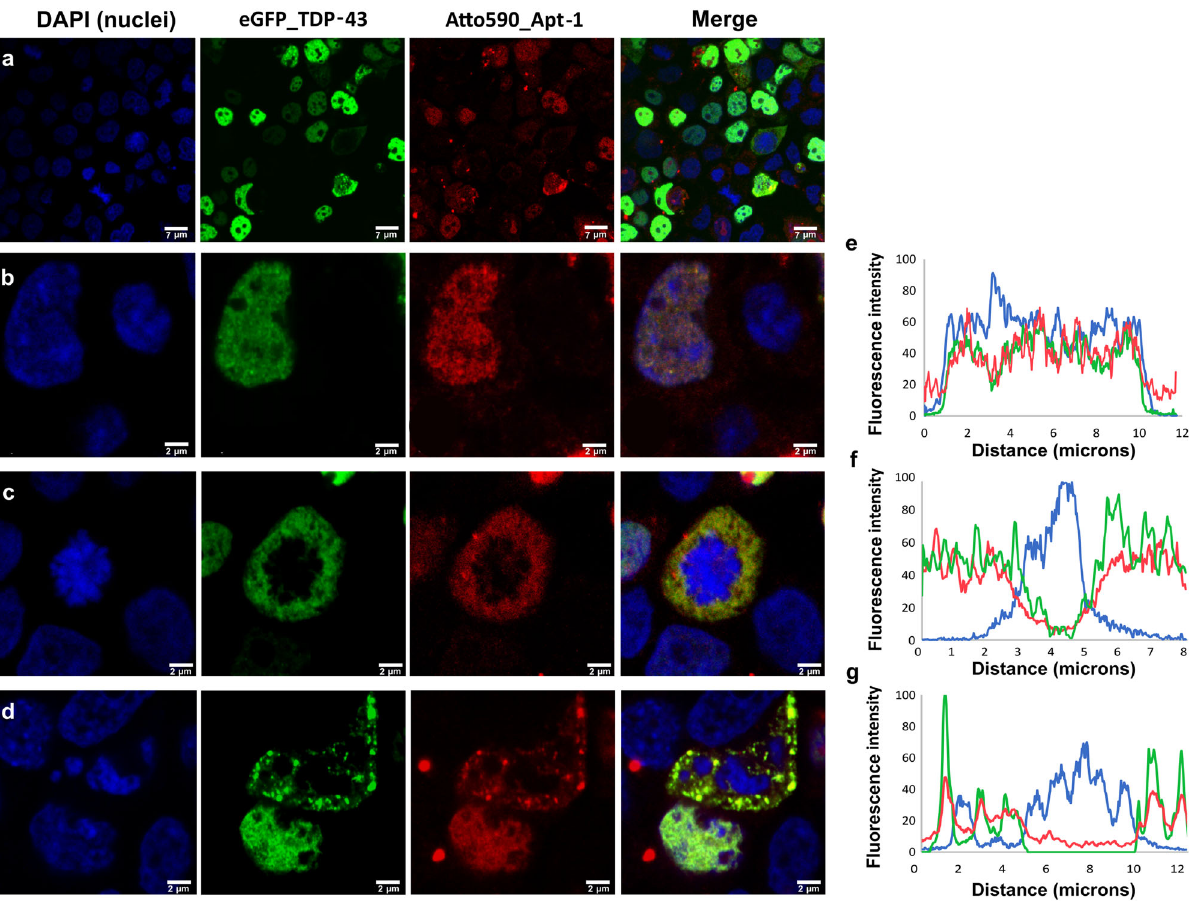
Fig. 6 Confocal microscopy analysis of TDP-43 and Apt-1 in live mammalian cells. Blue: DAPI; green: eGFP_TDP-43; red: Apt-1_Atto590. a Wide view of Hek293T cells co-transfected with the plasmid for the overexpression of full-length TDP-43 fused to eGFP and the aptamer Apt-1 conjugated to the fl uorophore Atto590. b – d Examples of isolated cells co-transfected as in ( a ), in which the correlation between green and red fl uorescence distribution is evident. e – g Fluorescence pro fi les of DAPI, eGFP, and Atto590 along a diagonal line drew across the isolated correspondent cells on the left, showing corresponding distribution of the fl uorescence signals of eGFP_TDP-43 and